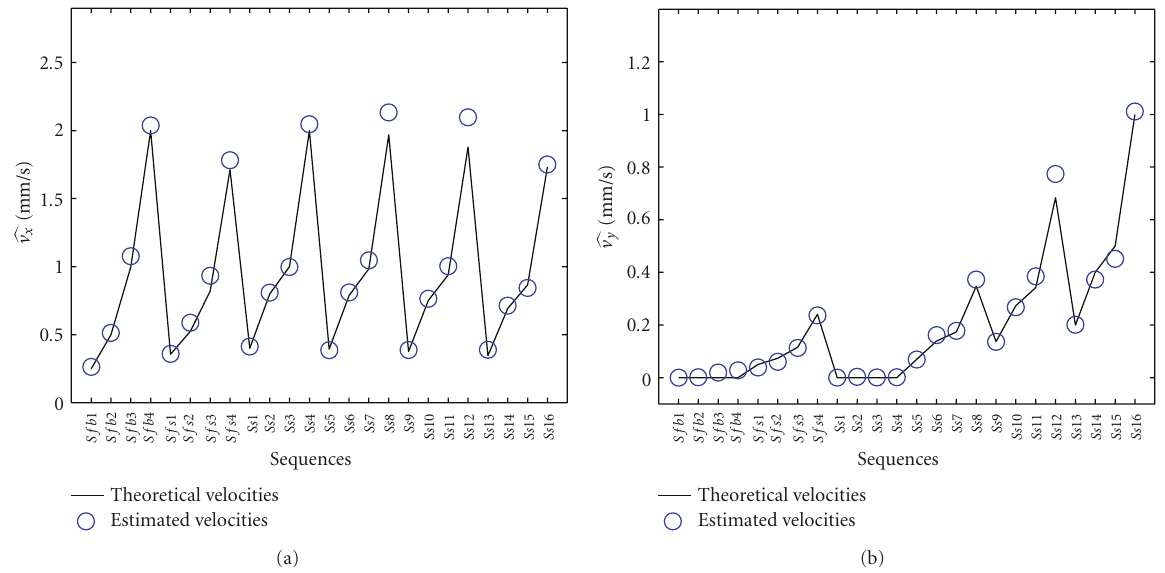
Figure 11: For each sequence, (a) estimated mean velocity (cid:17) v x , (b) estimated mean velocity (cid:13) v y .